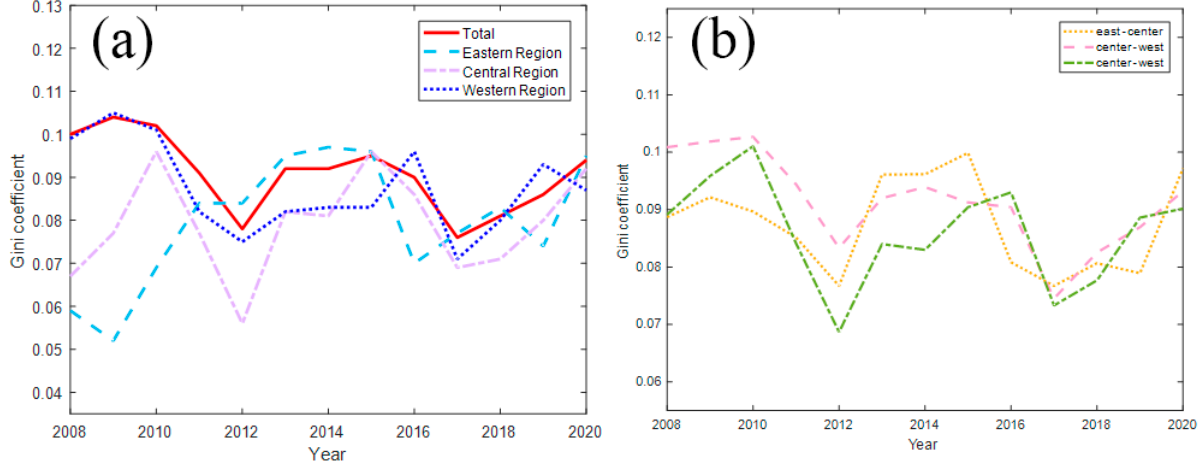
Figure 3. ( a ) Overall and intra-regional SDED differences; ( b ) inter-regional SDED differences. Data source: Table 4.